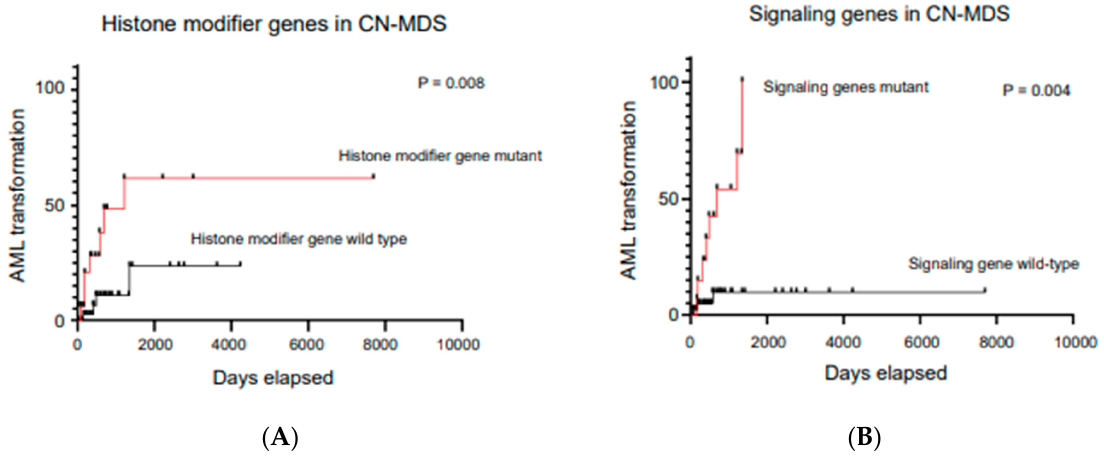
Figure 5. ( A,B ). Data showing AML transformation occurring significantly faster in patients who acquire histone modifier gene and signaling gene mutations at initial diagnosis. Adapted from Tria et al. [58] .